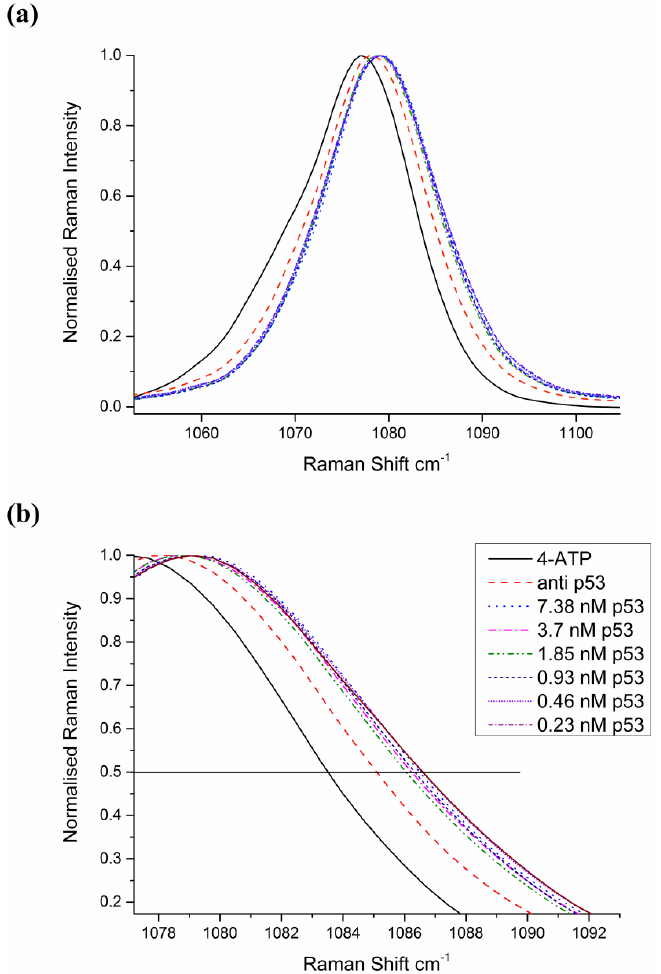
Figure 6. ( a ) Close up of the 1080 cm −1 peak for a range of concentrations of p53 protein. The lowest concentration shows the greatest red shift, but peak shift is not linear and is difficult to ascertain; ( b ) Zoom of region of forward edge of the 1080 cm −1 peak, showing influence of protein concentration on the spectrum of